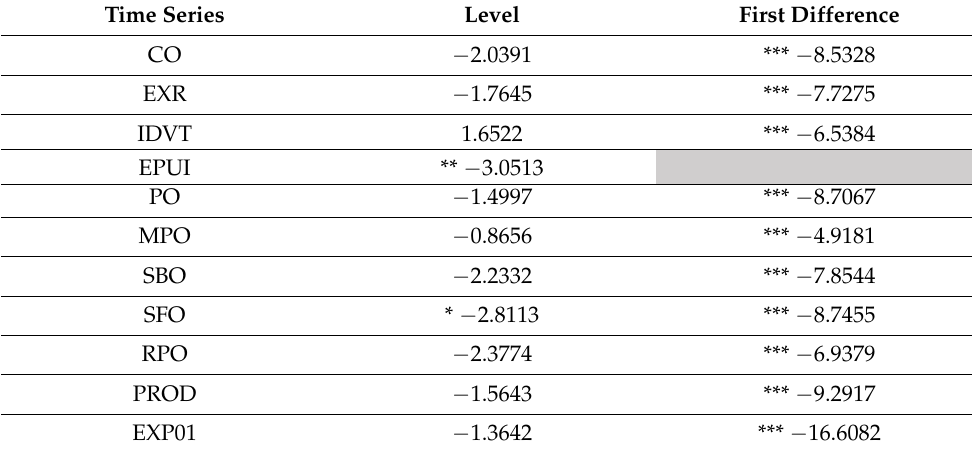
Table 1. Summary of the Augmented Dickey–Fuller (ADF) stationarity test outcomes (constant, with no trend). Time Series Level First